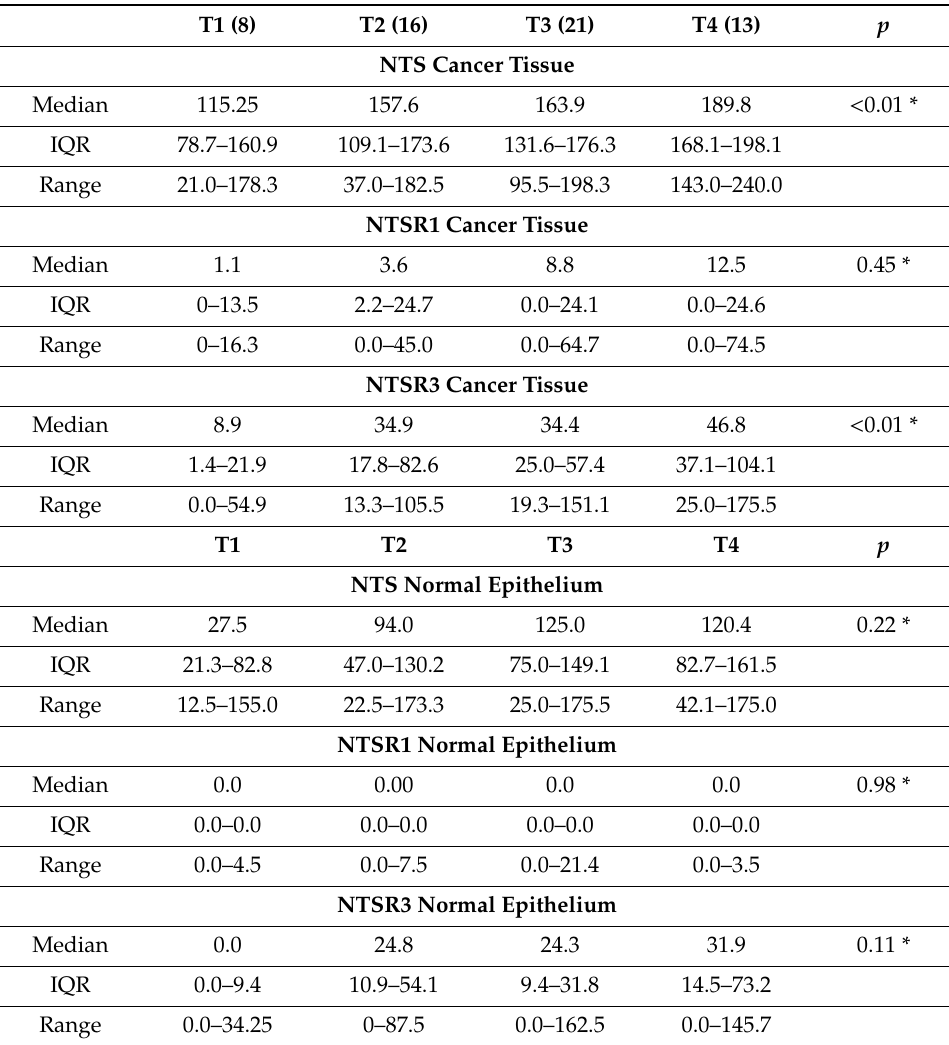
Table 3. H-scores of expressions of NTS, NTSR1 and NTSR3 across di ff erent cancer T stages. * Independent sample Kruskal-Wallis